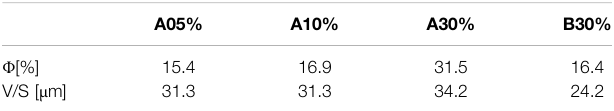
TABLE 2 | Porosities Φ and pores ’ volume to surface ratio V/S of different